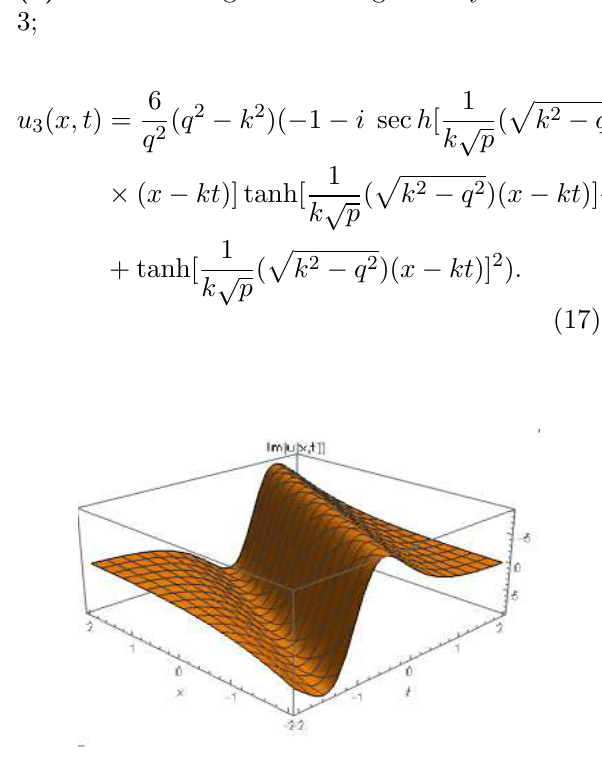
Figure 3. The 2D and 3D shape for the imaginary and real part of Eq. (16) with the values k = 2, p = 1, µ = 3, 5 < x < 8, 0 < t < 2 and − t = 0 for the graphics of